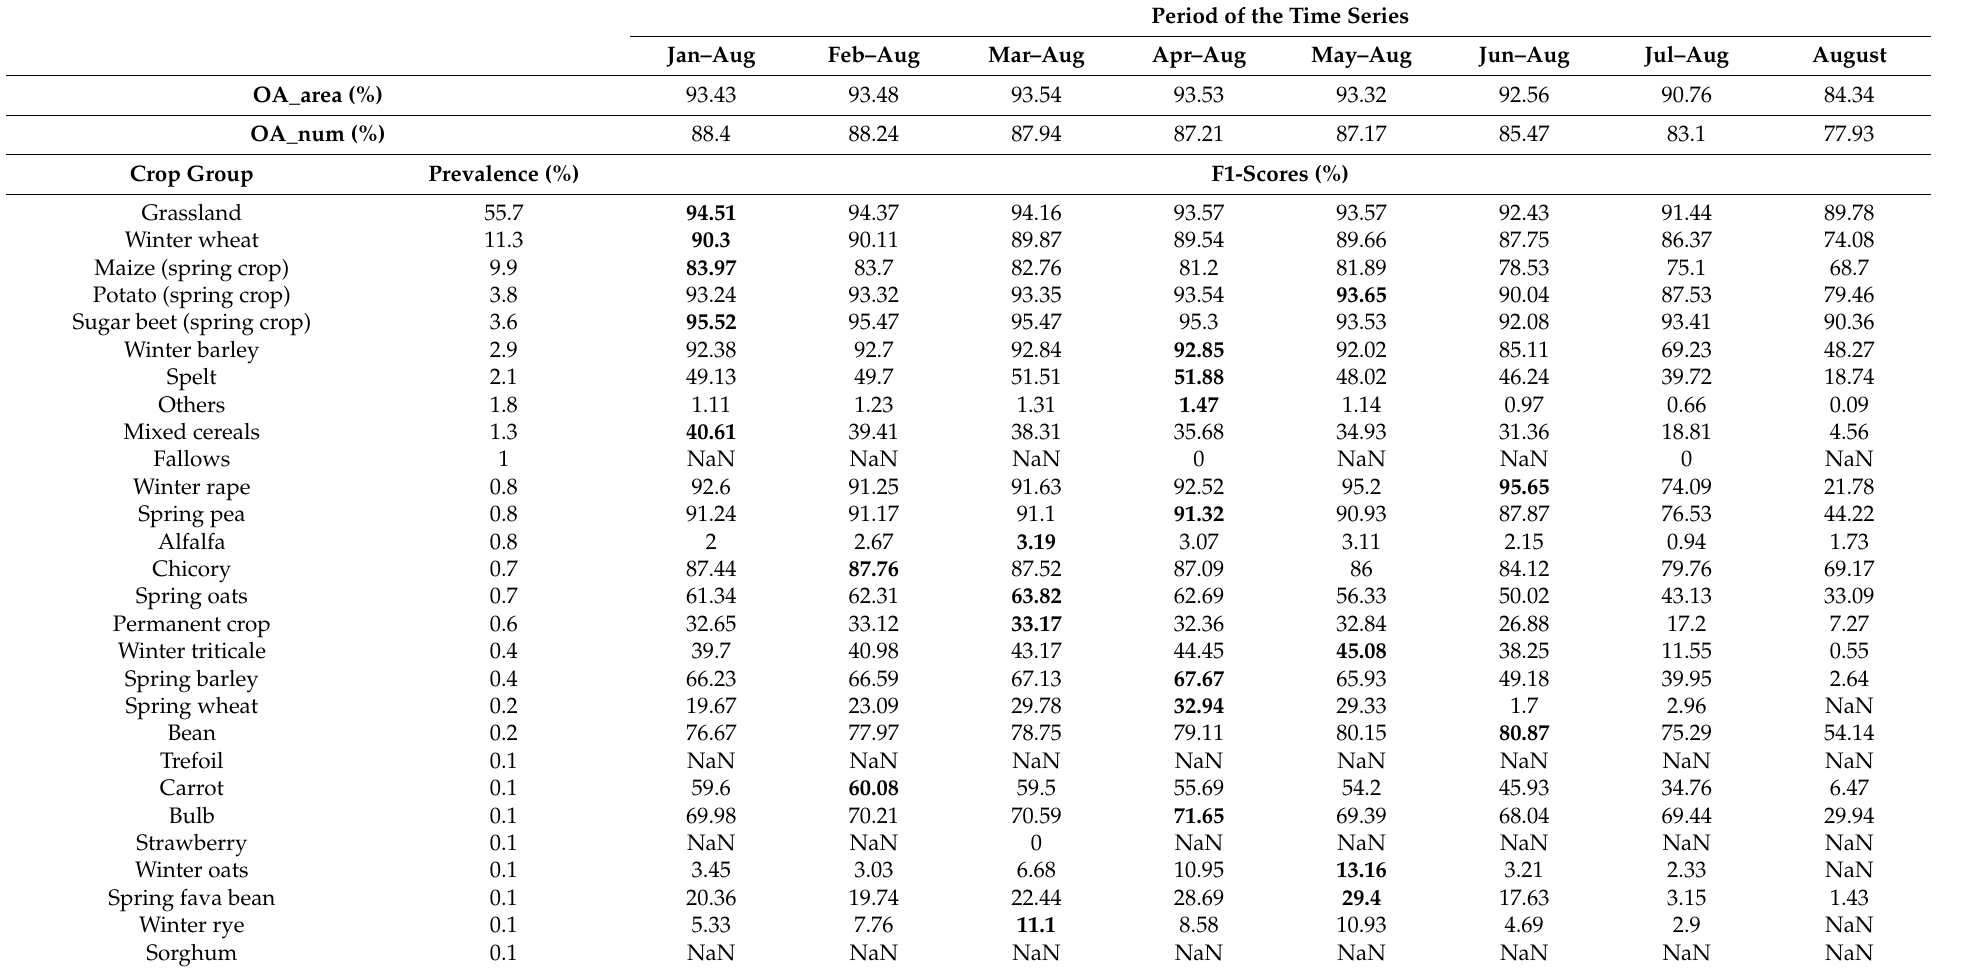
Table 7. Overall Accuracies and crop group F1-scores considering different periods for the SAR time series (beginning from January up to August